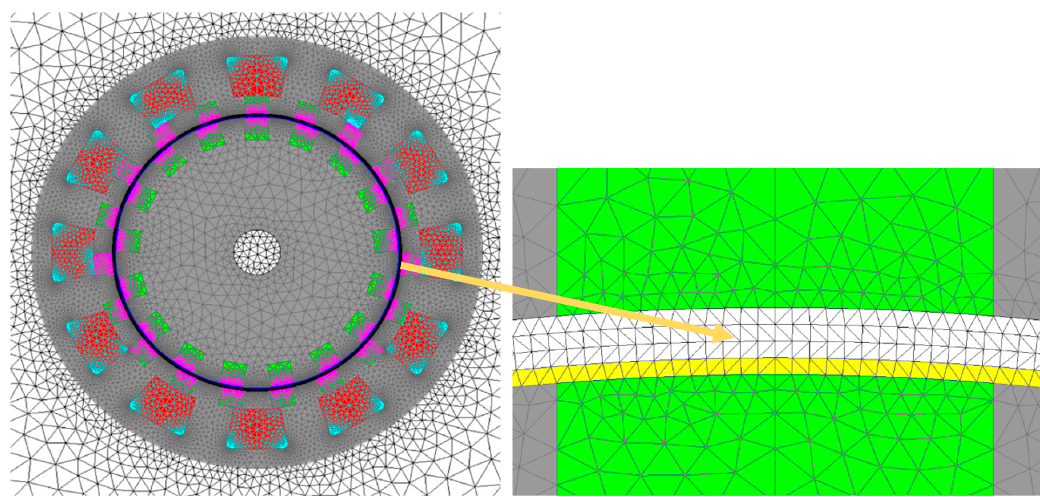
Figure 9. Final DPMM design with mesh distribution.